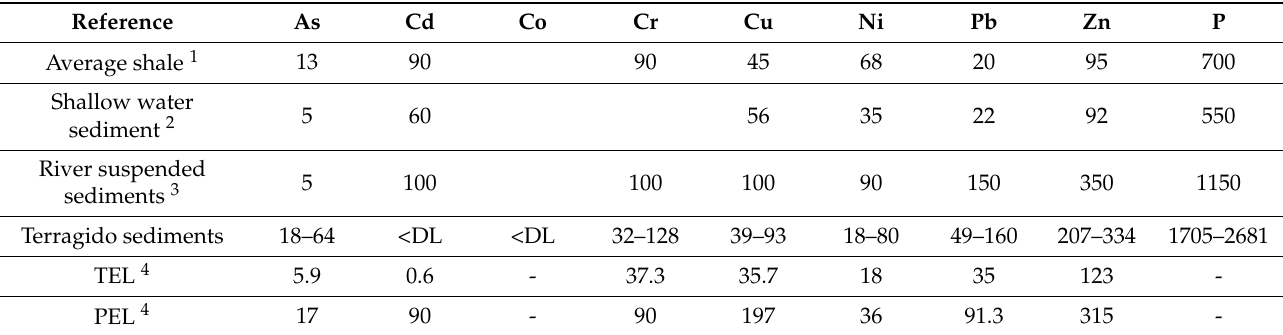
Table 2. Comparison of the ranges of concentrations ( µ g g − 1 ) of metals and As in the bottom sediments from the Terragido reservoir (fraction ≤ 63 µ m) with the mean contents in average shale, shallow water sediment, river-suspended sediment and PEL, LEL and PEL